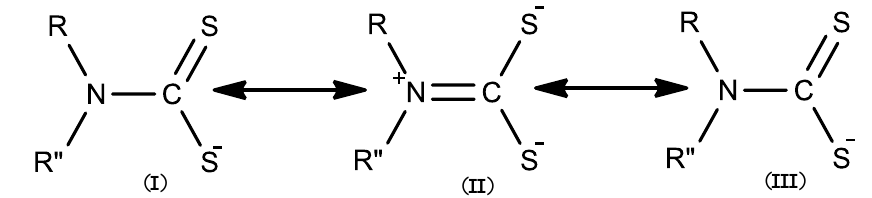
Figure 3. Resonance structure of dithiocarbamate.